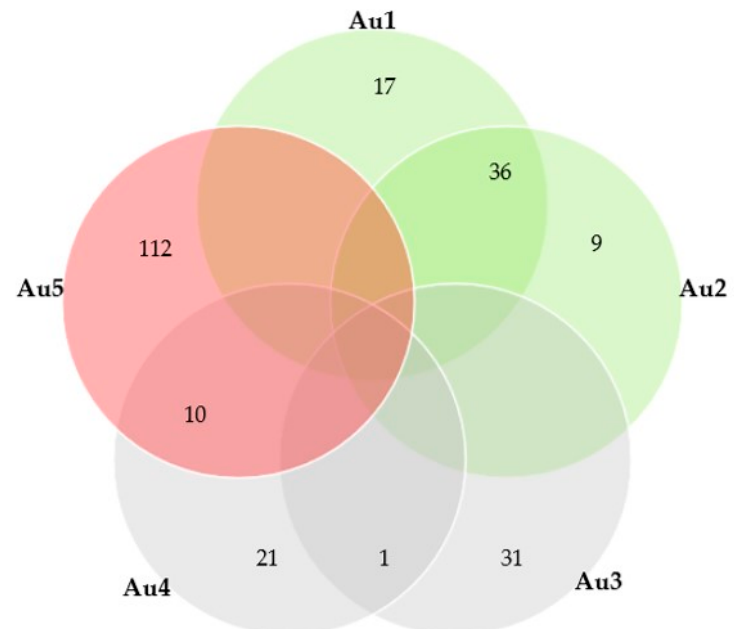
Figure 5. Venn diagram of numbers of papers published by each of the five individuals with at least 27 papers each as first or last author on their own and of numbers of the respective collaborative papers (grey shapes: authors affiliated with Aristotle University of Thessaloniki, burgundy shape: author affiliated with University of Thessaly, green shapes: authors affiliated with Agricultural University of Athens; Au1-5: descriptors for the five authors, with characterising numbers in random order).